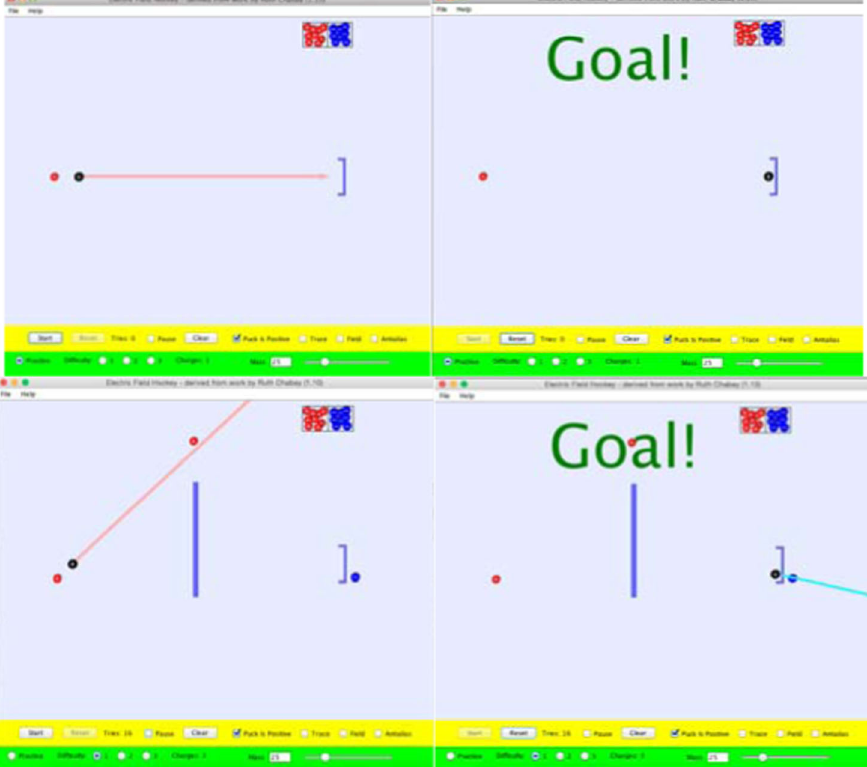
FIG. 3. Reproduced screenshots of students playing the Electric Field Hockey game. Top left: Students ’ strategy for the Practice Level. Top right: Result of students ’ strategy. Bottom left: Students ’ successful strategy for Level 1. Bottom right: Result of students ’